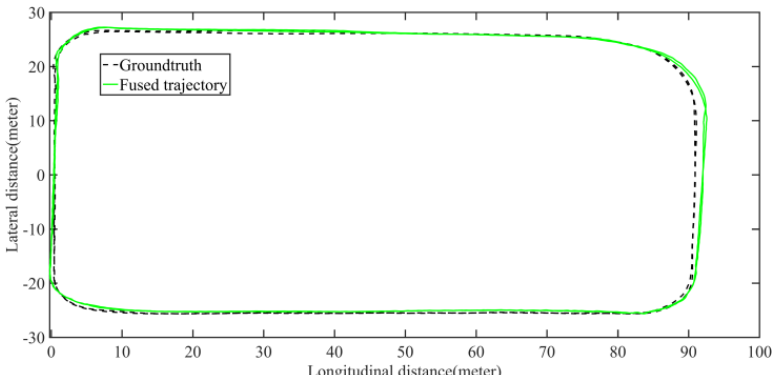
Figure 26. Field test NO.3. Two laps under normal driving scenario localization test in prior point cloud map. The white points in the figure are the point cloud map built by the offline mapping process, the red line is the trajectory of LiDAR matching results, the orange line is groundtruth, and the blue line is the fused trajectory.